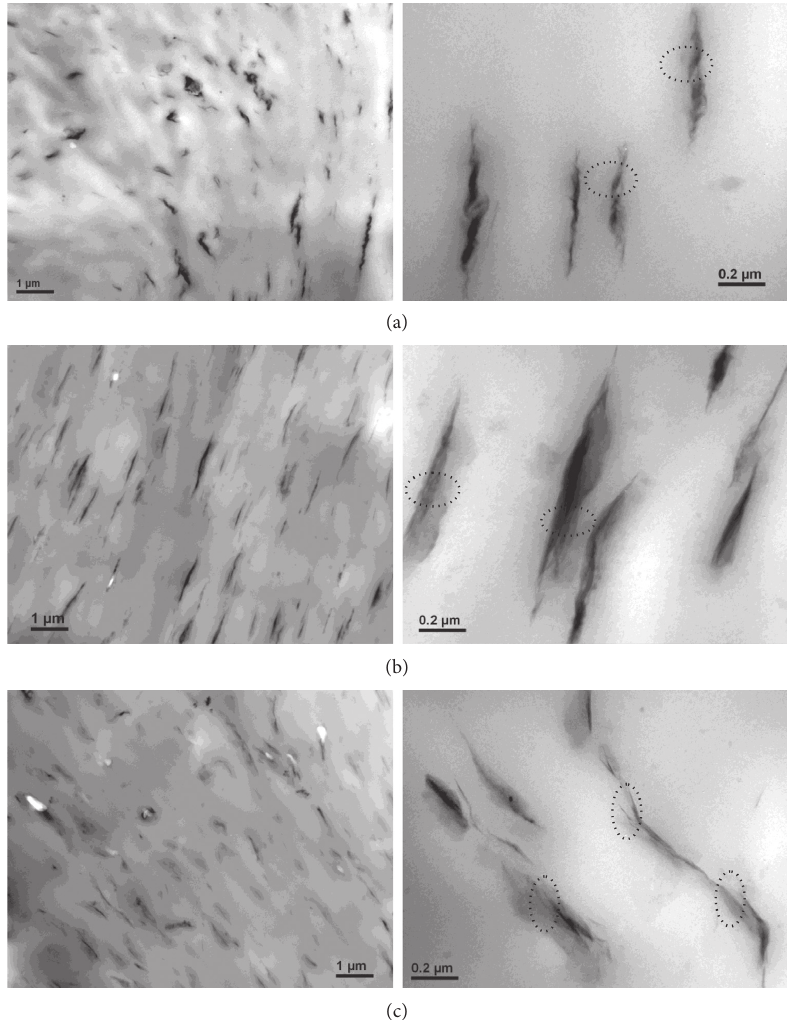
Figure 1: TEM micrographs of PP/o-MMTof trials 0, 16, and 21. (a) Trial 0 (PP/o-MMT � 40:1wt, o-MMTwithout pretreatment), (b) trial 21 (PP/o-MMT/DCP/MAH � 40:1: 1: 3 wt, o-MMT without pretreatment), (c) trial 16 (PP/(o-MMT/DCP)/MAH � 40:2:3 wt, DCP preconfined in o-MMT with the ratio